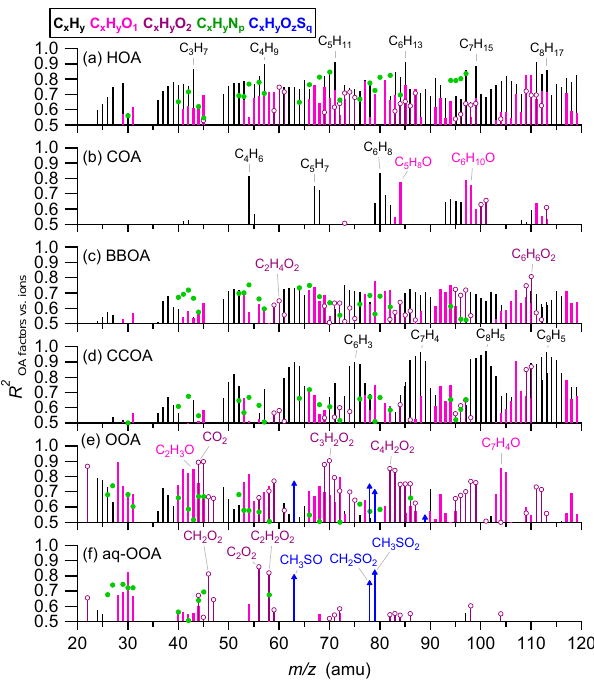
Figure 8. Correlations between six OA factors and HRMS ions that are segregated into five categories (C x H + y , C x H y O + , C x H y O + C x H y N + p and C x H y O z S + q